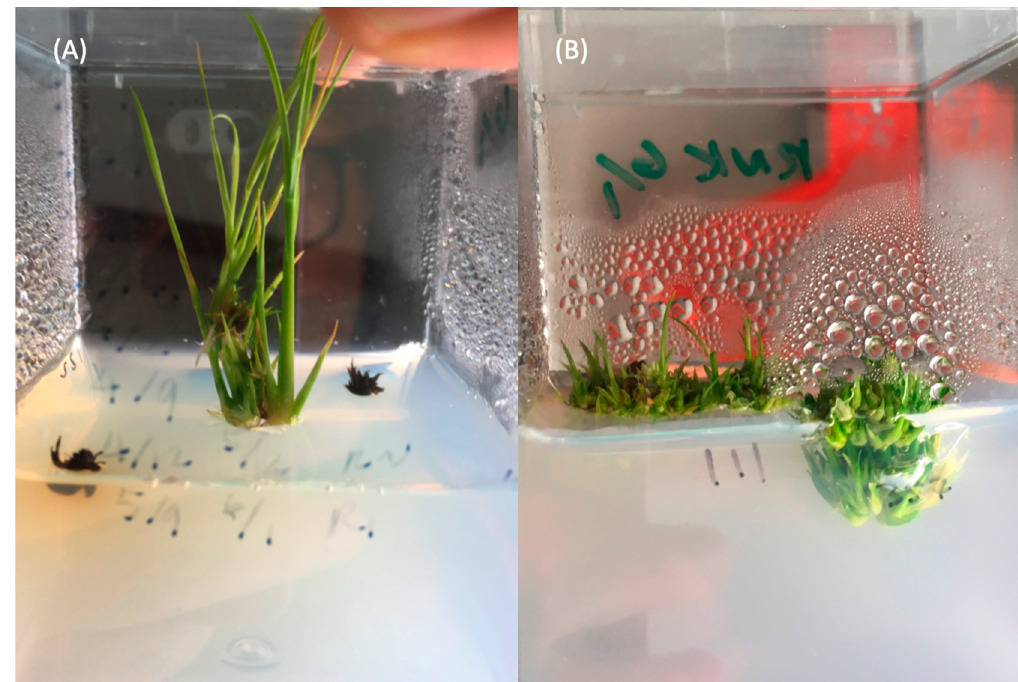
Figure 2. Performance of Ciherang-Sub1 calli in regeneration media. ( A ) Calli in the SIM medium (optimized medium); and ( B ) calli in regeneration medium for type 4 indica varieties [15] .